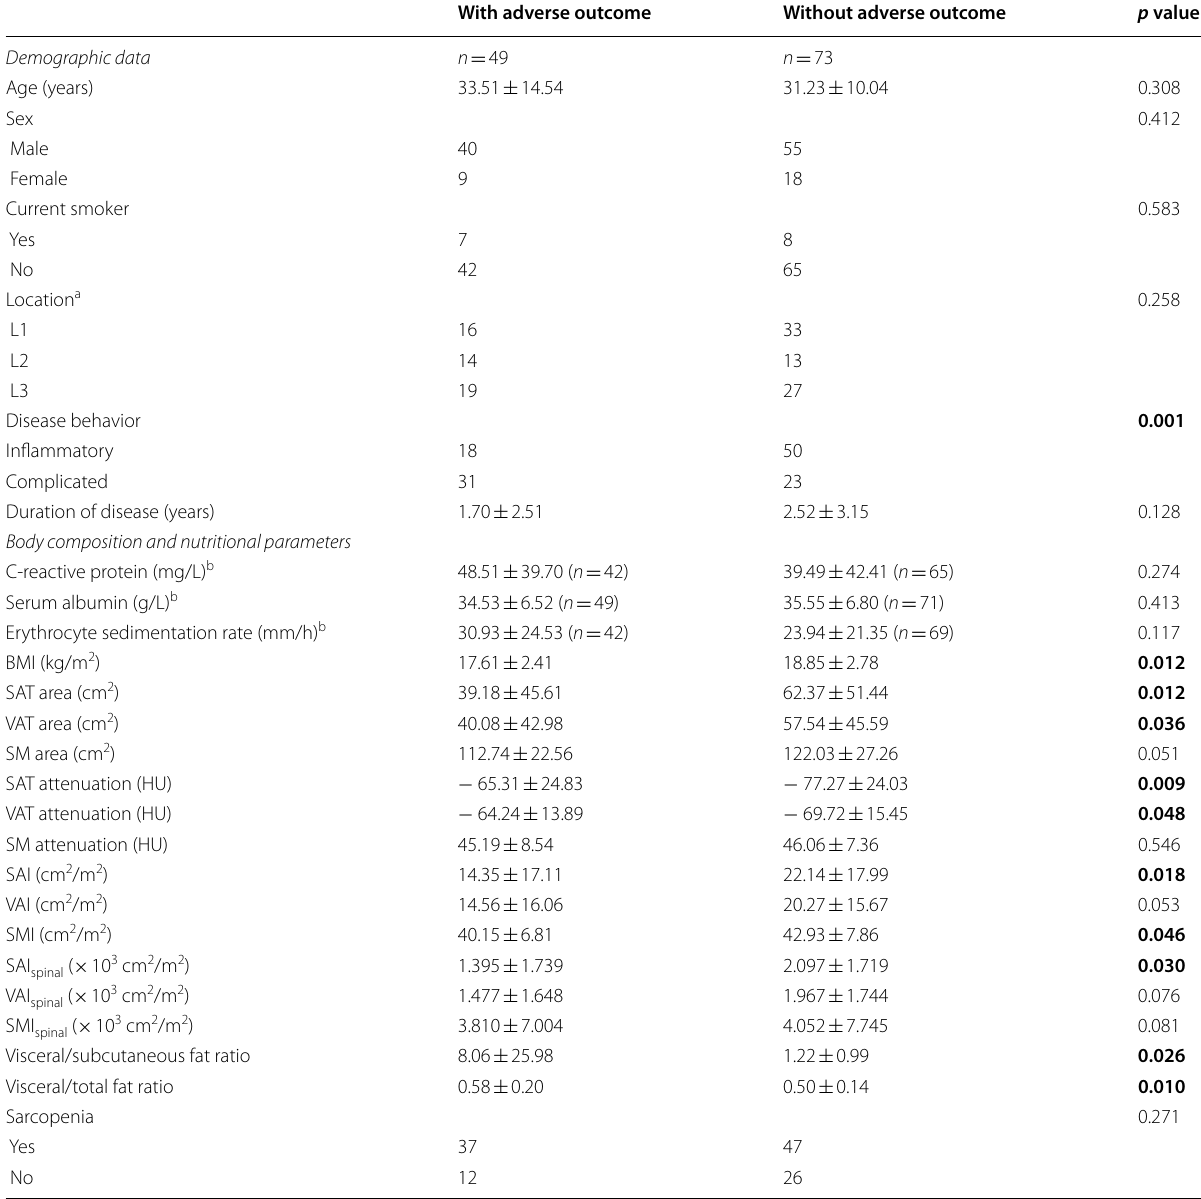
Continuous data are expressed as means